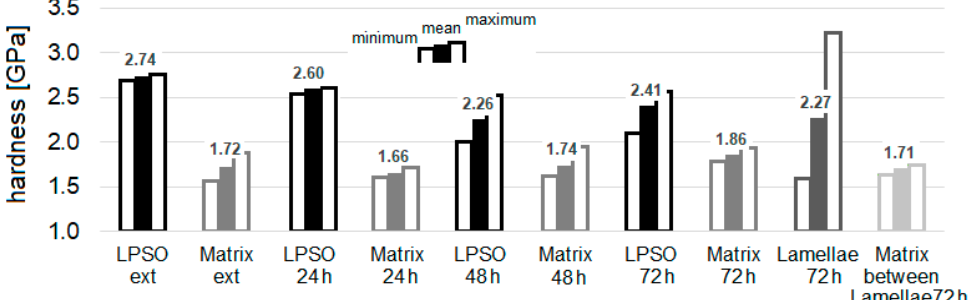
Figure 16. Minimum, mean, and maximum values of the hardness of the multi ‐ cycle indents in Mg ‐ Dy ‐ Nd ‐ Zn ‐ Zr alloy, in the range 100–300 nm in depth, in the as ‐ extruded and the solution heat ‐ treated conditions at 500 °C for 24 h, 48 h, and 72 h: in the blocky LPSO phases, in the matrix without LPSO lamellae and for 72 h in the region of narrow LPSO lamellae as well as in the matrix in between lamellae with wider distances.